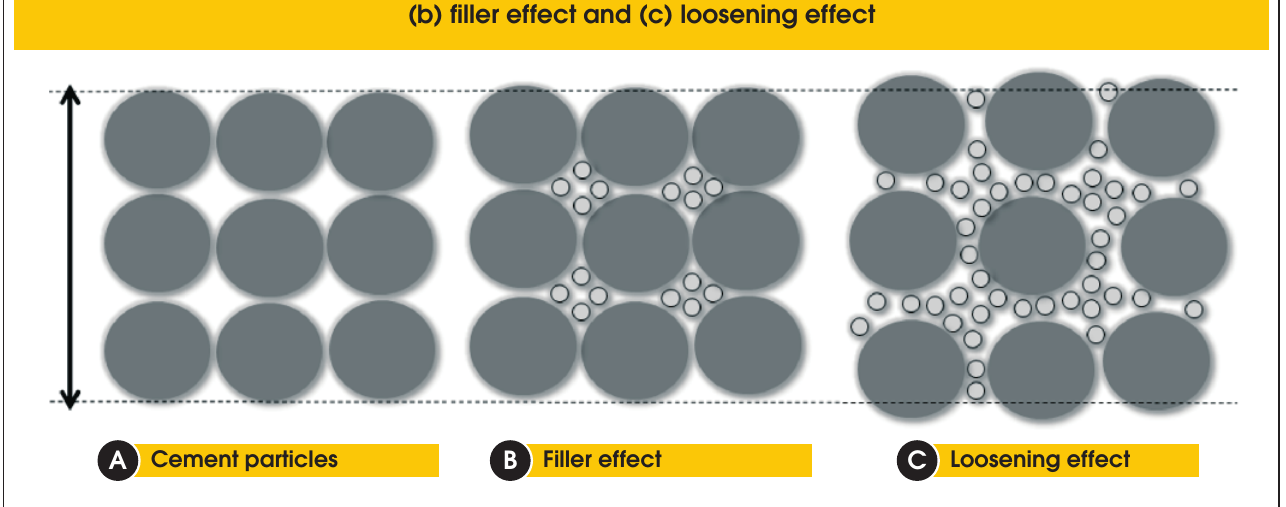
Figure 1 – Physical effects of silica fume on (a) the cement particles: (b) filler effect and (c) loosening